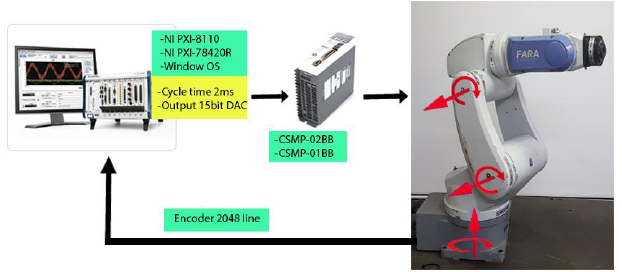
13 of 18 Figure 5. Tracking error results. Blue line is [30]+ESO controller. Red line is the proposed control- ler. ( a ) Joint 1; ( b ) Joint 2; ( c ) Joint (3). Remark 5. From the results in Simulation 1 and 2, it can be seen that the different kinds of faults can highly affect the performance of the active fault-tolerant control strategy despite having similar magnitude at the actuators. Therefore, to prevent the effect of faults, AFTC needs a different solu- tion for the way it deals with uncertainties and disturbances. AFTC with the conventional control- ler technique may not be enough to guarantee an acceptable performance in the robot manipulators when faults occur. In contrast, with the synchronization technique, the proposed AFTC showed effectiveness in tolerating faults despite this technique having no effect in the normal operation mode. 6. Experimental Results 6.1. Experiment Setup The experimental setup is shown in Figure 6 and uses a 3-DOF FARA-AT2 robot ma-